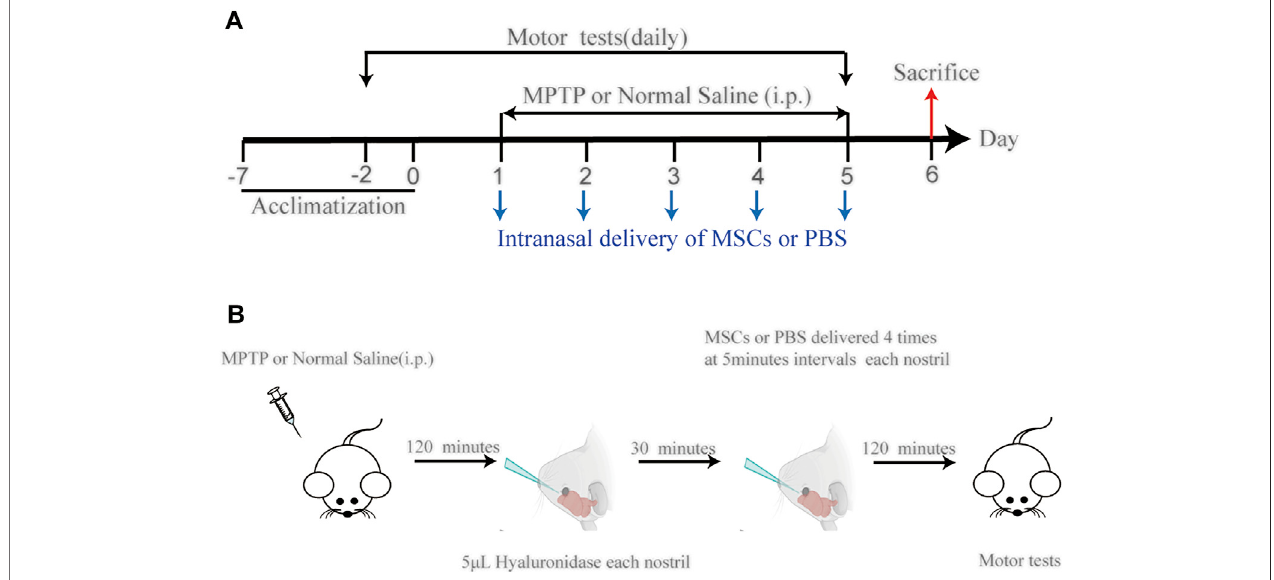
FIGURE1|(A) Schematicdiagramoftheexperimental design. (B) Diagramoftheexperimentalprocessbeforesamplecollection,amongwhichintranasal delivery schema can be found in Rhea EM et al. (2020). DOI:10.3390/pharmaceutics12111120.